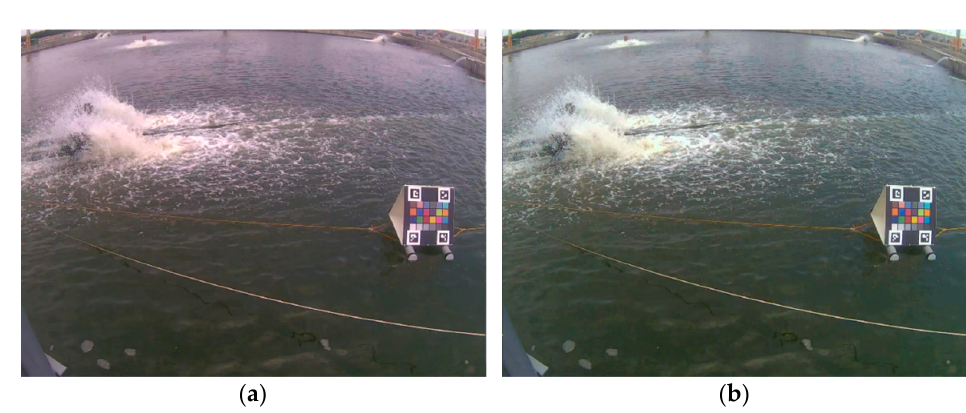
Figure 5. The images of a real scene: ( a ) original capture, and ( b ) after color correction.